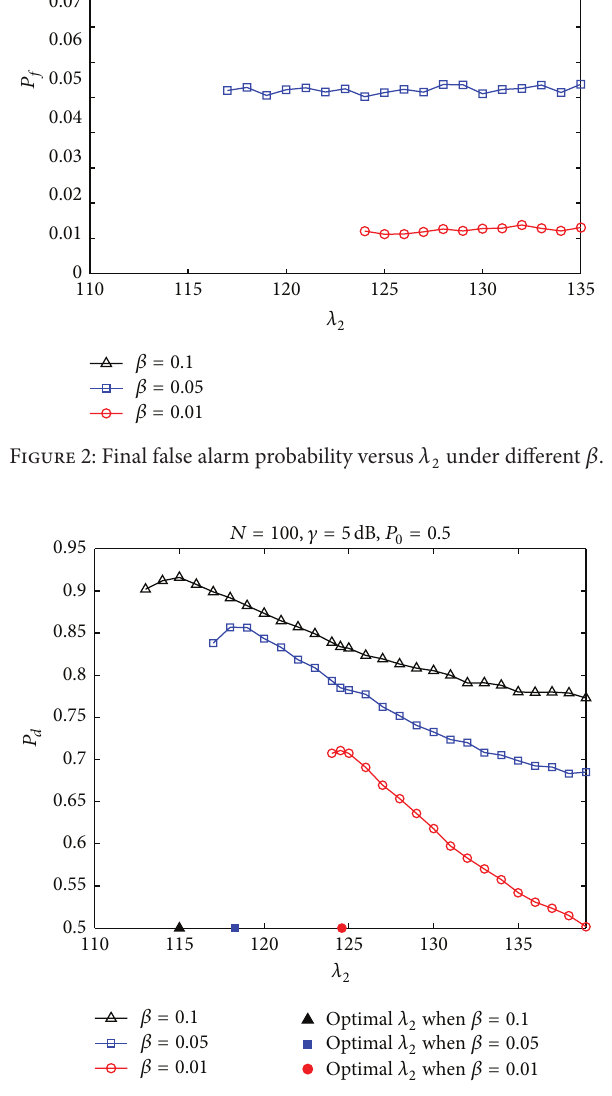
Figure 3: Final detection probability versus 𝜆 2 under different 𝛽